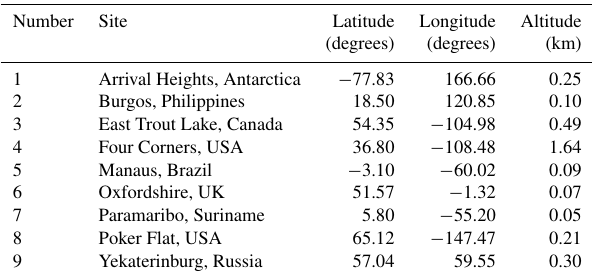
Figure 2. Distribution of the sensitivity of CO 2 concentrations (ppm(µmol(m 2 s) − 1 ) − 1 ) in Europe with respect to the concentra- tions in adjacent cells, calculated using the FLEXPART model with a resolution of 1.0 ◦ for TCCON operational sites within Europe, using a tracer simulation initialised at the level of 1000m. Table 2. Past, future and possible TCCON